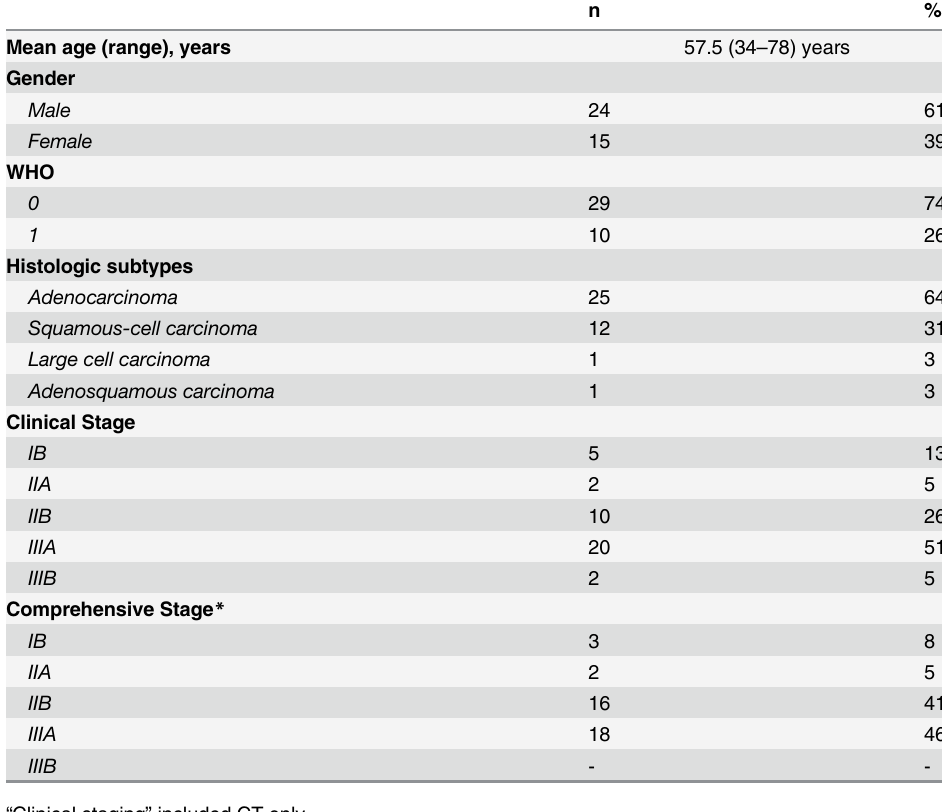
Table 1. Baseline demographics and clinical characteristics (n =